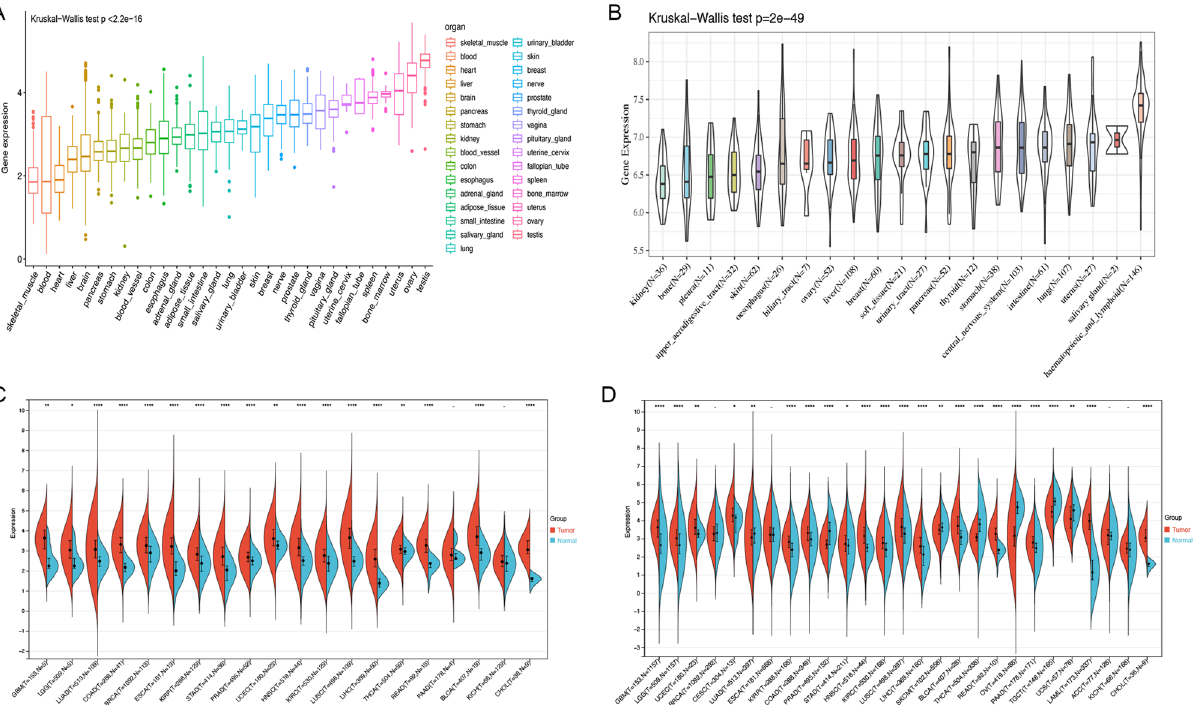
Figure 1. Differential expression of HAUS5. ( A ) HAUS5 expression in normal tissues from the GTEx database. ( B ) HAUS5 expression in tumor cell lines based on the CCLE database. ( C ) HAUS5 expression in 20 types of cancer in the TCGA database. ( D ) HAUS5 expression between tumor and normal samples from the TCGA and GTEx databases. *P < 0.05, **P < 0.01, ***P < 0.001, ****P <